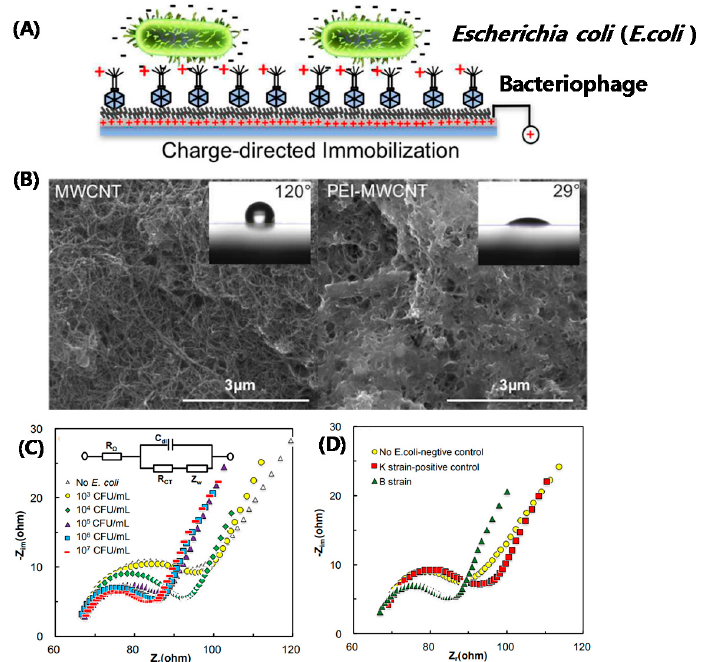
Figure 4. Charge-directed immobilization of T2-bacteriophage on CNT-based electrode of whole-cell electrochemical biosensors. ( A ) Schematic representation of the charge-directed orientation and immobilization of T2-bacteriophage onto PEI-functionalized CNT on an electrode surface. ( B ) SEM images of bare CNTs and PEI-modified CNTs. Inset: photographs of a water droplet on each substrate and their contact angles. ( C ) Nyquist plot of T2-modified electrodes in the absence and presence of E. coli B at di ff erent concentrations (Inset: Randles equivalent circuit), ( D ) Nyquist plot of T2-modified electrodes in the absence and presence (10 6 CFU / mL) of native host (B strain) and non-host (K strain) E. coli . Reproduced with permission from [30], Copyright @ 2017 American Chemical Society (Washington, DC,